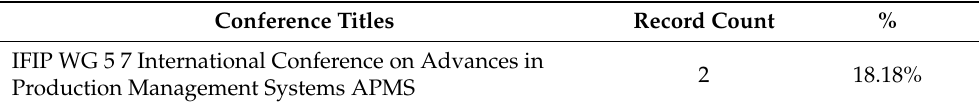
Table 7. Main source title which contributed to the publication of post-conference scientific publica- tions related to Logistics 4.0 in the SME sector; Source: own study.